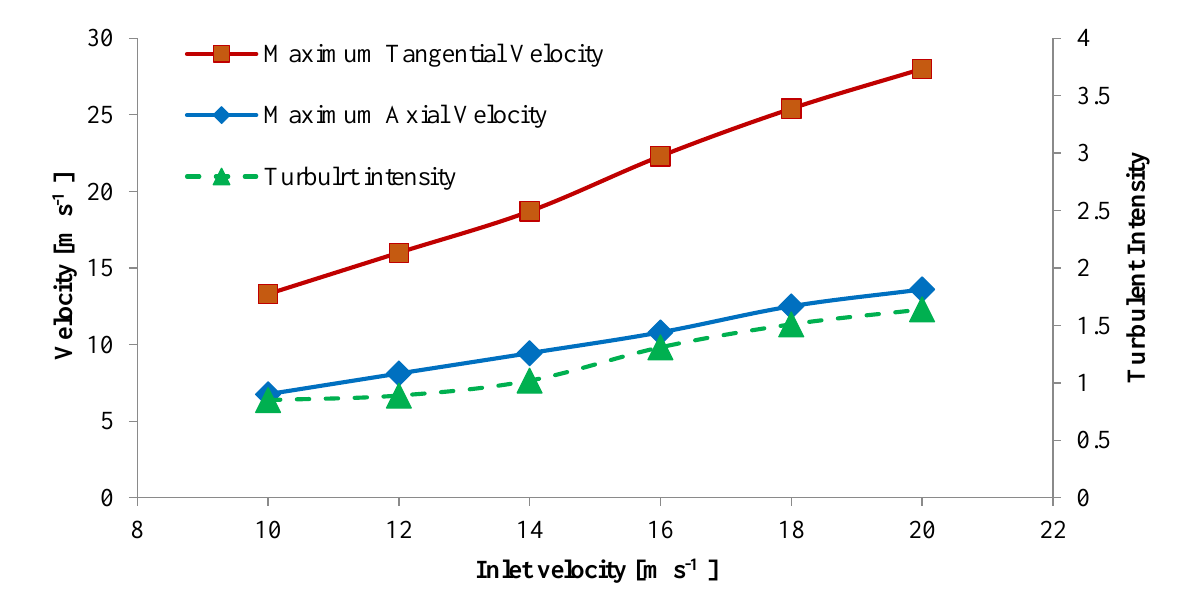
Figure 13. Variation of axial velocity, tangential velocity and turbulent intensity in various inlet velocities. The increase in the mass flow rate has an insignificant effect on the distribution of turbulent intensity. This trend is illustrated in Figure 14.